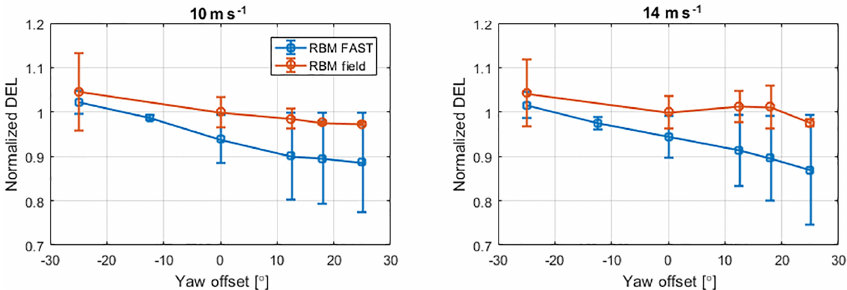
Figure A3. Comparison between predicted (FAST) and measured (field) RBM DELs. The largest component among eight load-rose sectors was selected for each yaw